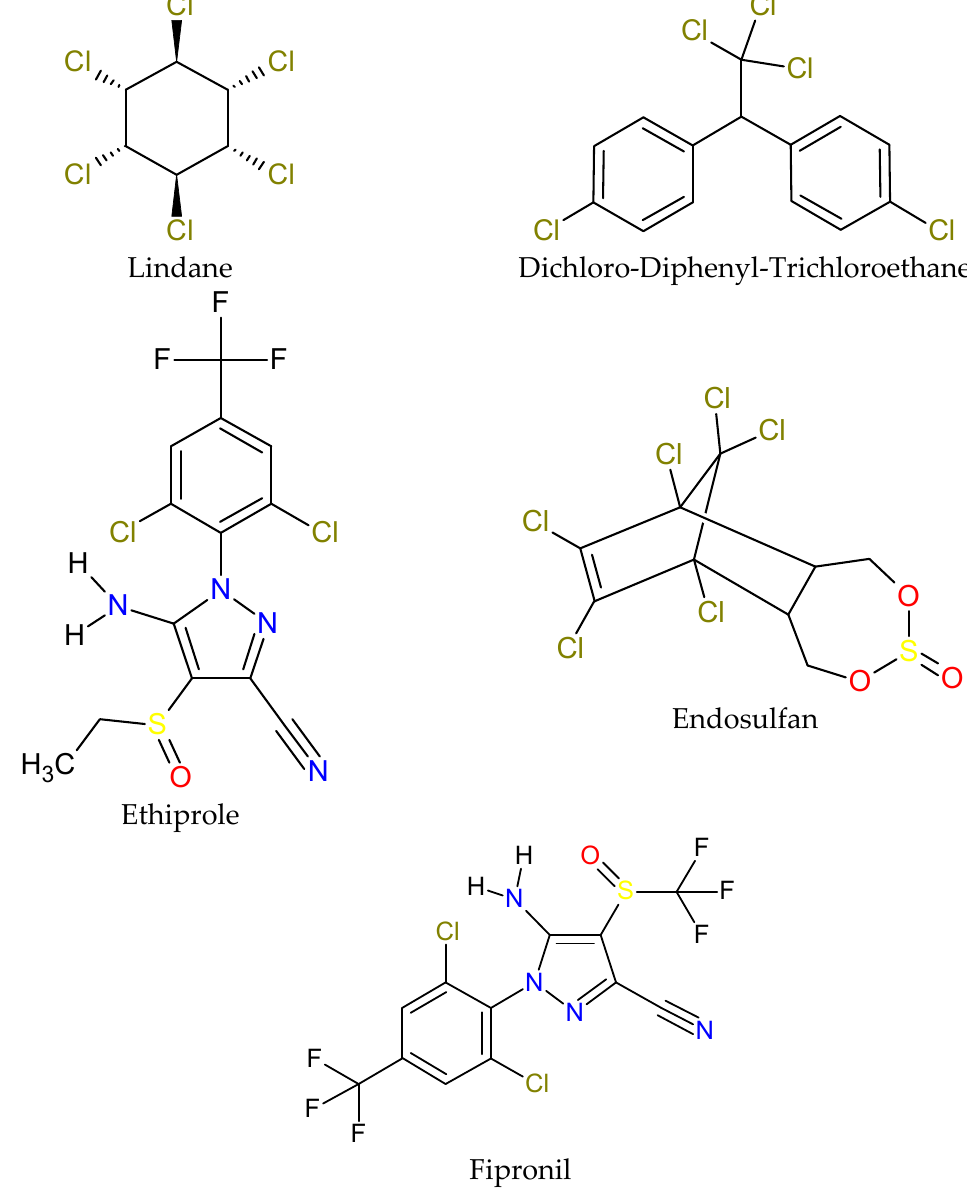
Figure 1. Structural formula of some of the major organochlorines (OCPs).